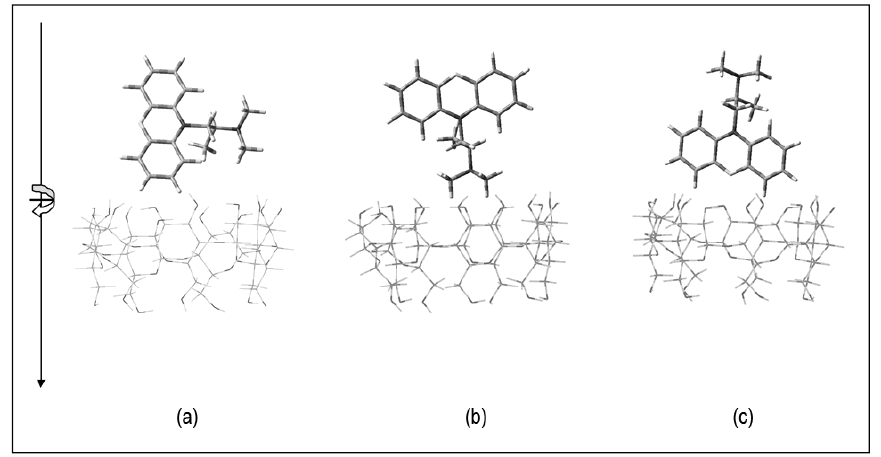
Figure 3. The three different orientations considered for the insertion of promethazine into the cavity of the host molecules with the N atom from the alkyl group of promethazine moving in (a) vertically, (b) facing up, and (c) down